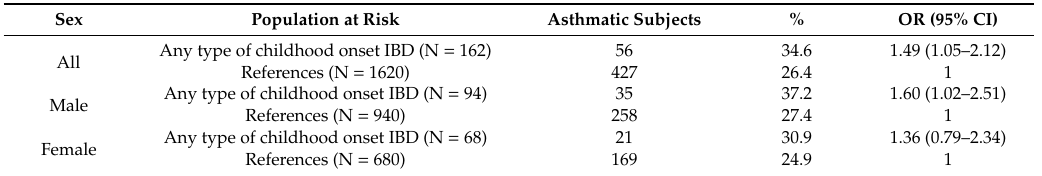
Table 2. Risk of Asthma among Children A ff ected by IBD, Stratified by Sex. OR, Odds Ratio; CI, Confidence Interval.